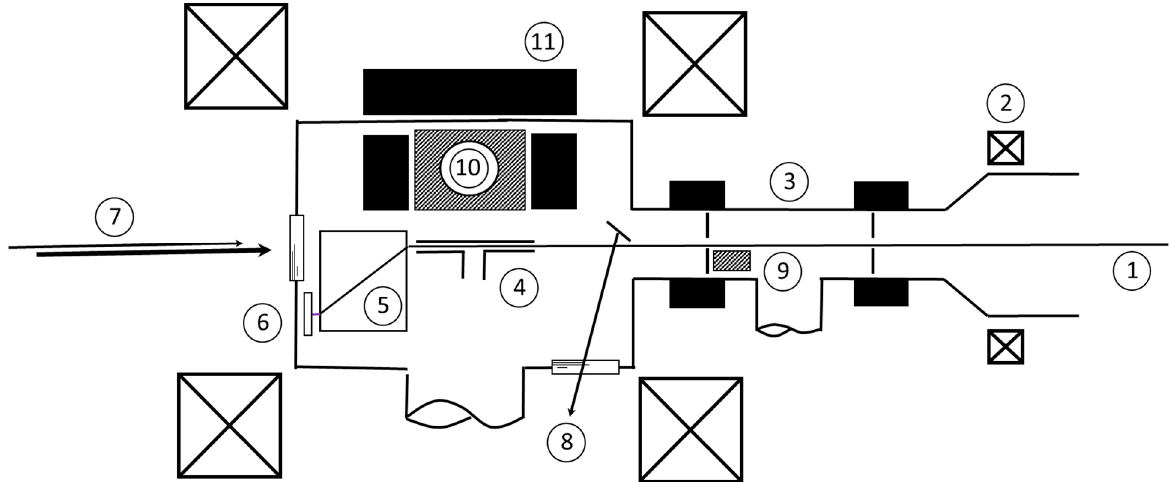
Figure 2. Schematic diagram of the positron polarimeter showing (1) terminus of the Surko buffer gas trap and incident positron beam guided by (2) solenoidal magnets; (3) differential pumping section; (4) the heated, optically pumped Rb target; (5) trochoidal beam deflector that directs the positrons to a beam dump (6); (7) optical pumping and probe lasers; 980 reflected probe beam to monitor Rb polarization; (8) reflected probe beam used to measure Rb polarization; (9) (NaI) scintillators (cross-hatched regions) that provide the event detection; (10) the target photomultiplier tube, and (11) Pb blocks to keep stray gamma rays from striking the